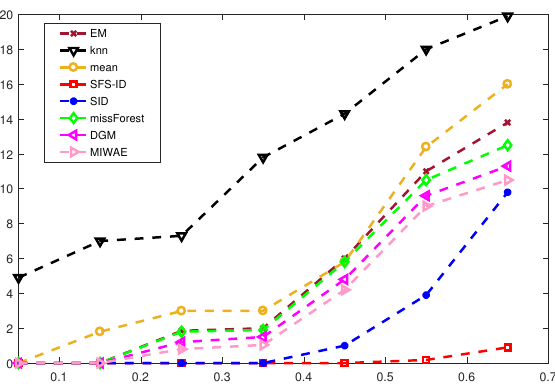
Figure 4. The number of irrelevant features selected, together with two relevant features.